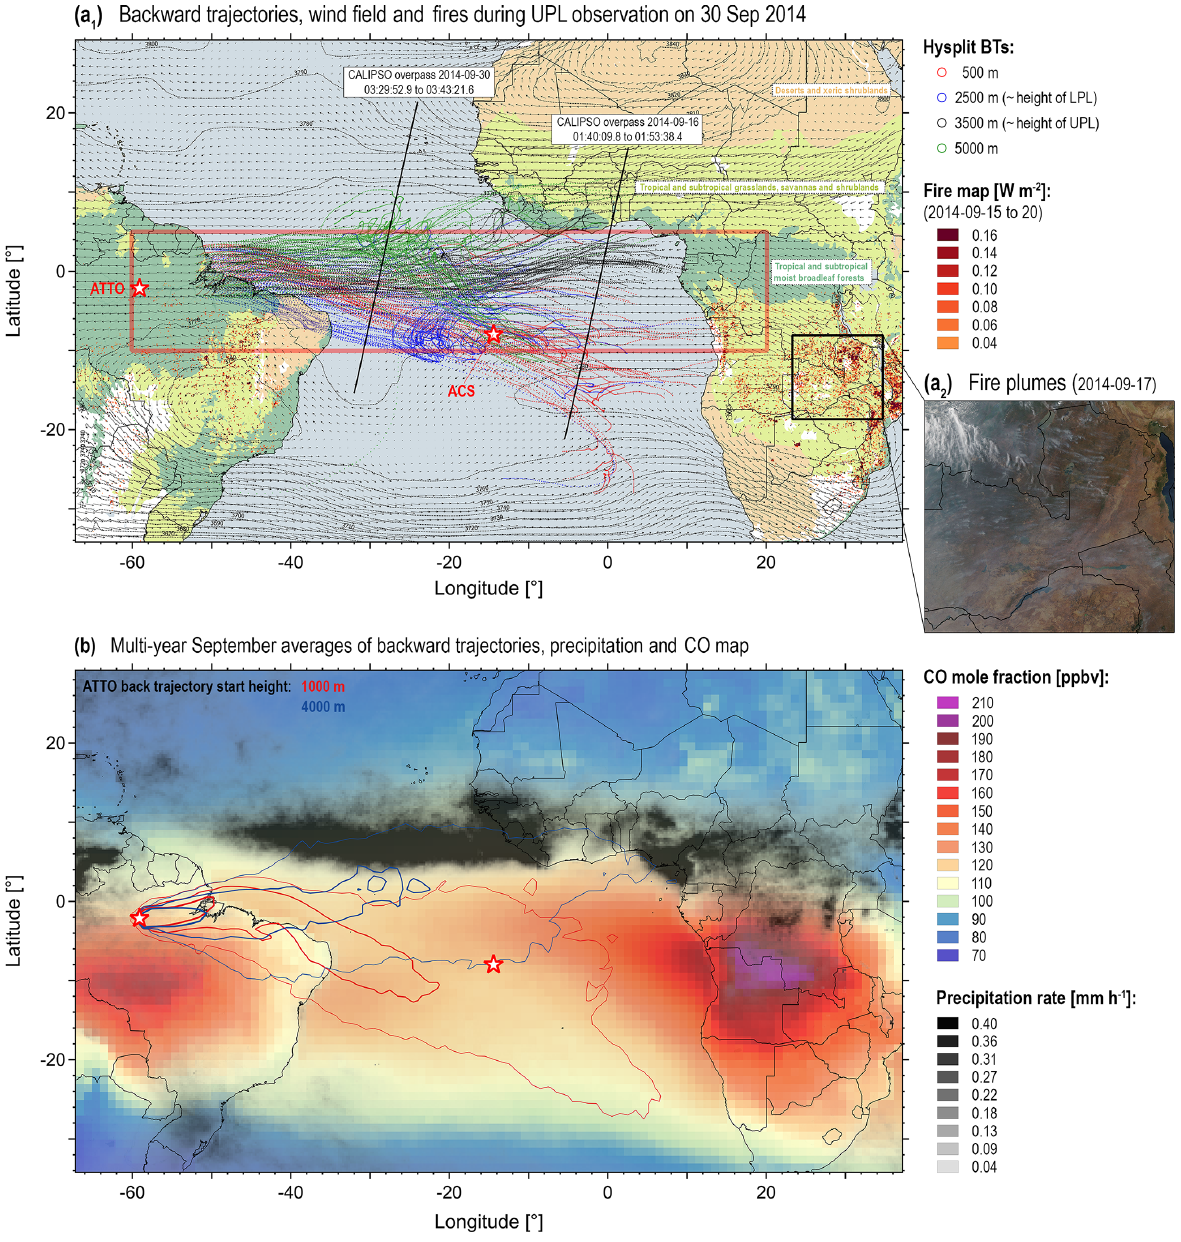
Figure 7. Composite maps combining backward trajectories (BTs) and satellite data products characterizing atmospheric conditions (a 1 ) dur- ing flight AC19 on 30 September 2014 in comparison to (b) the averages of September observations during multiple years. Panel (a 1 ) shows HYSPLIT 10d BTs starting at different altitudes (500, 2500, 3500, 5000ma.g.l.) at 18:00UTC on 30 September 2014 (similar time and location to the UPL observations during flight AC19). Note that the altitudes where the BTs were initiated include the heights of the sam- pled UPL and LPL. The fire radiative power (FRP) density (mWm − 2 ), retrieved by the Global Fire Assimilation System (GFAS v1.0) averaged from 15 to 20 September 2014, is also shown as a fire map with 0.1 ◦ × 0.1 ◦ grid resolution. The orbits of two CALIPSO pas- sages on 30 and 16 September 2014 as shown in Fig. 9 as well as the geographic locations of the ATTO site and Ascension Island are also illustrated. Panel (a 2 ) shows multiple clearly visible fire plumes in the African source region. Panel (b) shows multi-year averages of all Septembers for (i) HYSPLIT BT ensembles starting at ATTO (1000 and 4000ma.g.l.) from 2005 to 2018. Contour lines repre- sent the fraction of occurrence of overpassing trajectories in a specific region as described in Pöhlker et al. (2019). (ii) AIRS-derived CO data products (400 to 600hPa atmospheric levels) from 2005 to 2018 and (iii) TRMM precipitation from 2005 to 2018. For gen- eral illustration, animations (https://climate.nasa.gov/climate_resources/146/video-simulated-clouds-and-aerosols/, last access: 4 July 2019; https://gmao.gsfc.nasa.gov/research/aerosol/modeling/nr1_movie/, last access: 4 July 2019) of the Goddard Earth Observing Model (Version 5, GEOS-5) show that aerosol particles are transported efficiently from Africa to South America and to a lesser extent from South America to Africa (Colarco et al., 2010; Yasunari et al.,